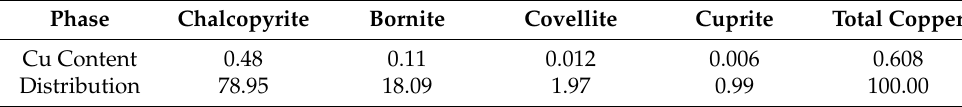
Table 3. Copper chemical phase analysis of the polymetallic ore